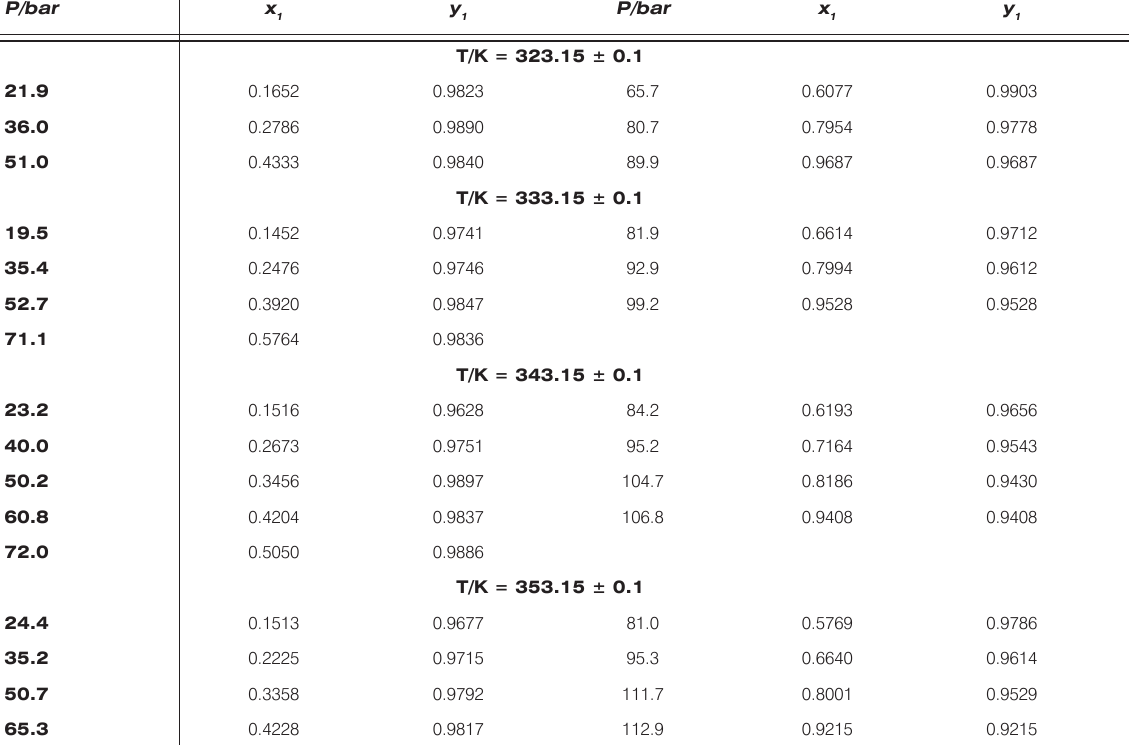
Table 2. Mole fractions of component 1 in the liquid phase x P and temperatures T for the binary system carbon dioxide (1) + 2-methyl-2-propanol (2). P/bar x